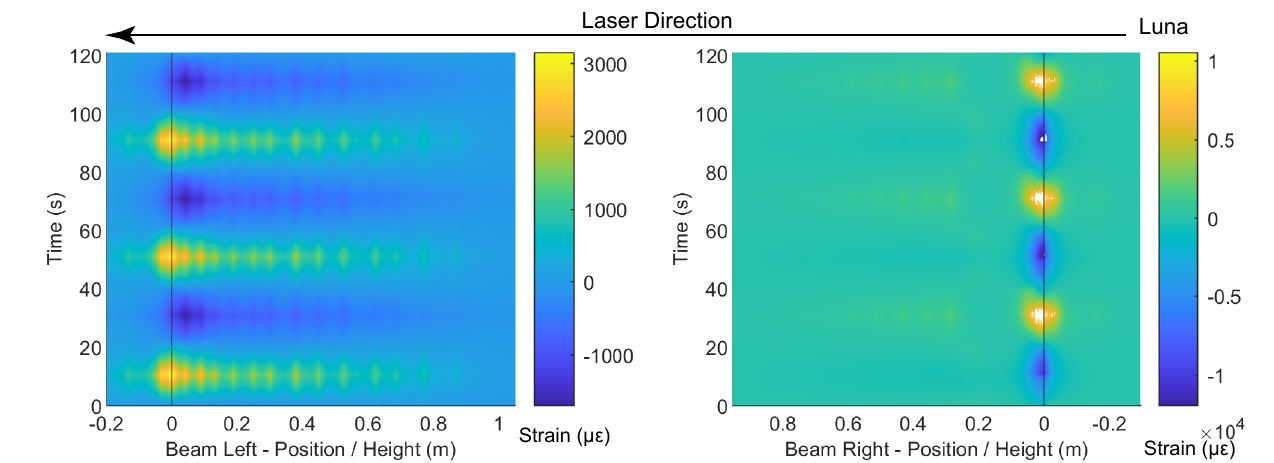
Figure 14. Contour of the fiber-optic strain measurements for PVC cable at a drift level of